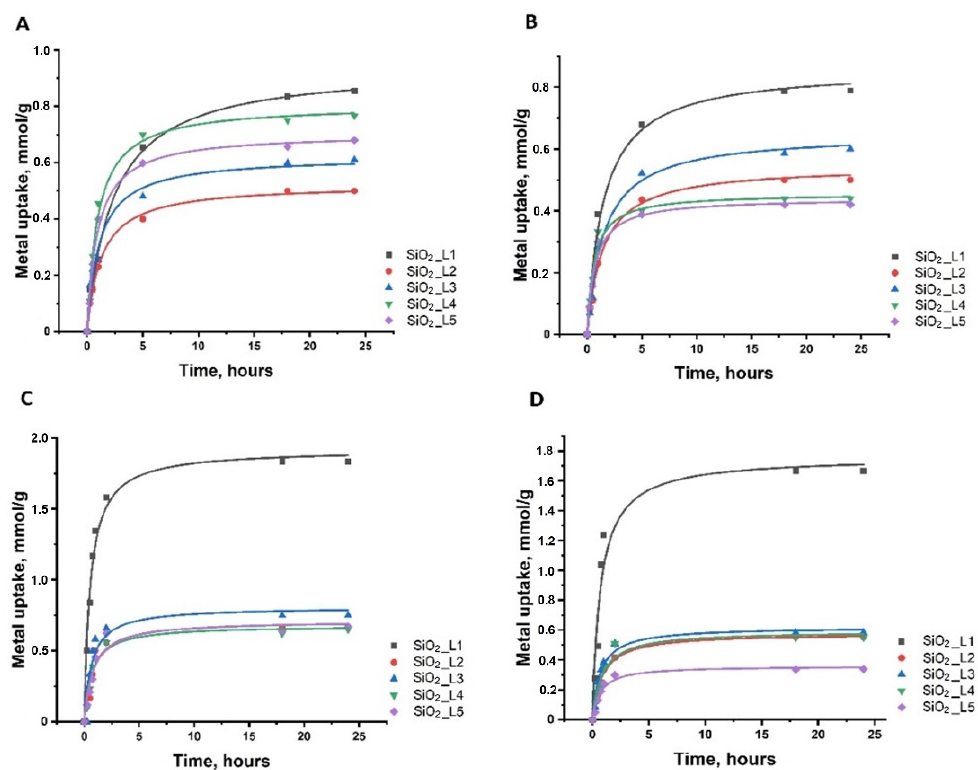
Figure 6. Adsorption kinetics of ( A ) Sm, ( B ) Nd, ( C ) Co and ( D ) Ni onto functionalized silica